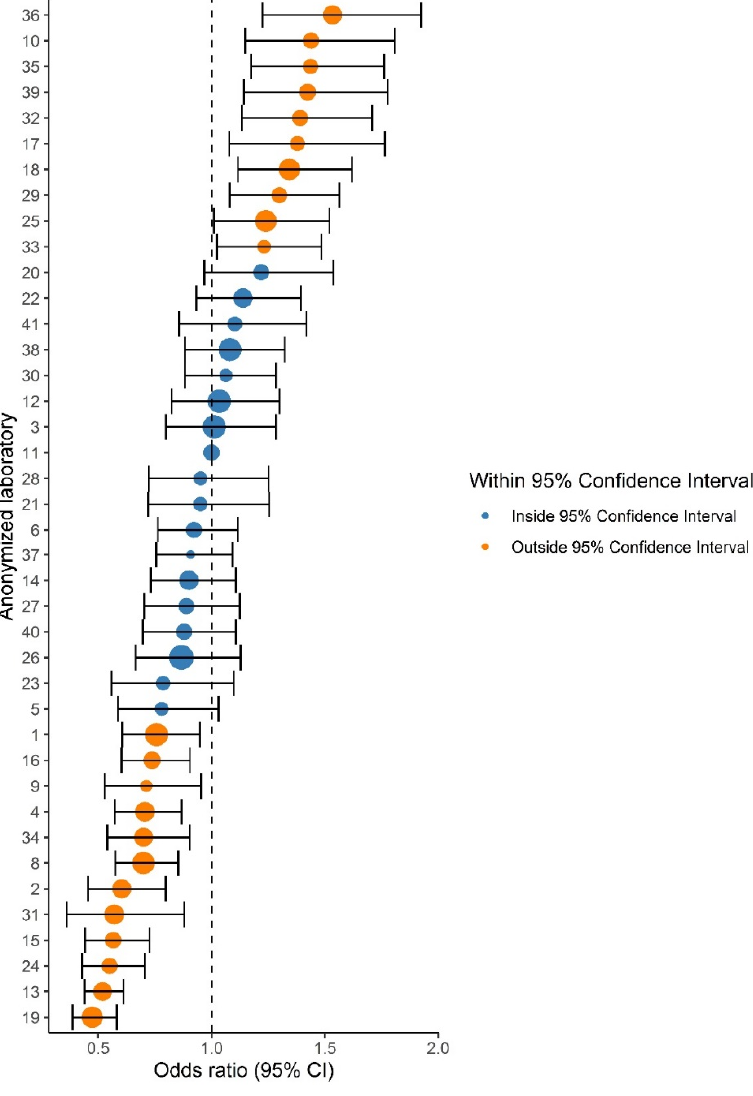
Figure 2. Forest plot showing the adjusted odds ratios (ORs) and 95% confidence intervals (CIs) of ISUP Grades 1 versus 2–5 prostate cancer grade in comparison to the reference laboratory (#11). Dot size indicates the total number of reported prostate cancers per laboratory. Orange dots indicate laboratories with a significantly deviant OR compared to the reference laboratory.